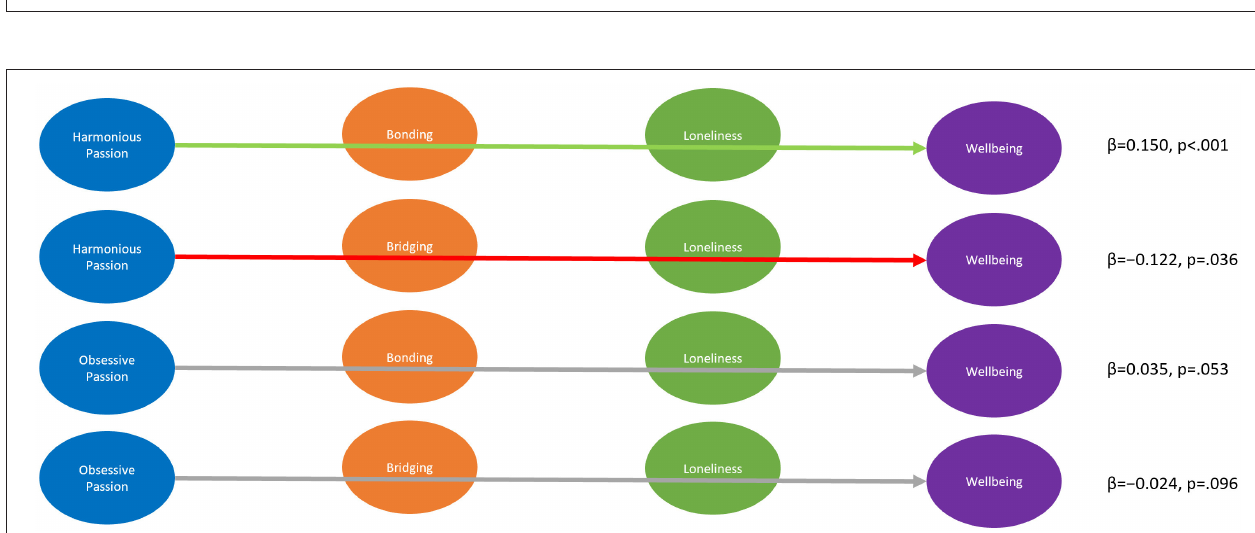
Frontiers in Psychology |